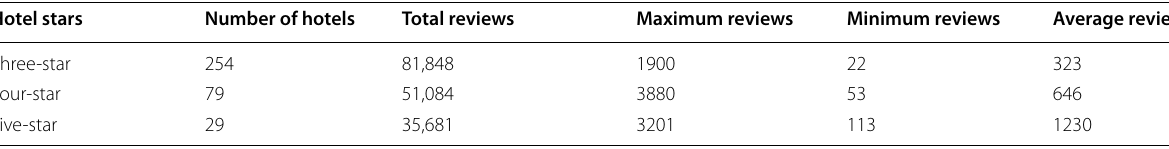
Table 1 Information on the number of reviews for each star hotel Hotel